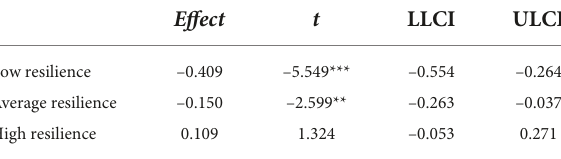
TABLE 5 Conditional effects of anxiety on life satisfaction at values of